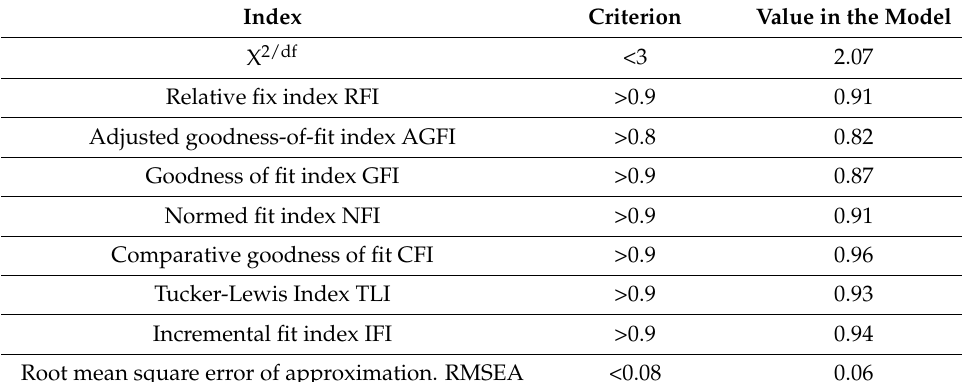
Table 5. Fits the index value in the